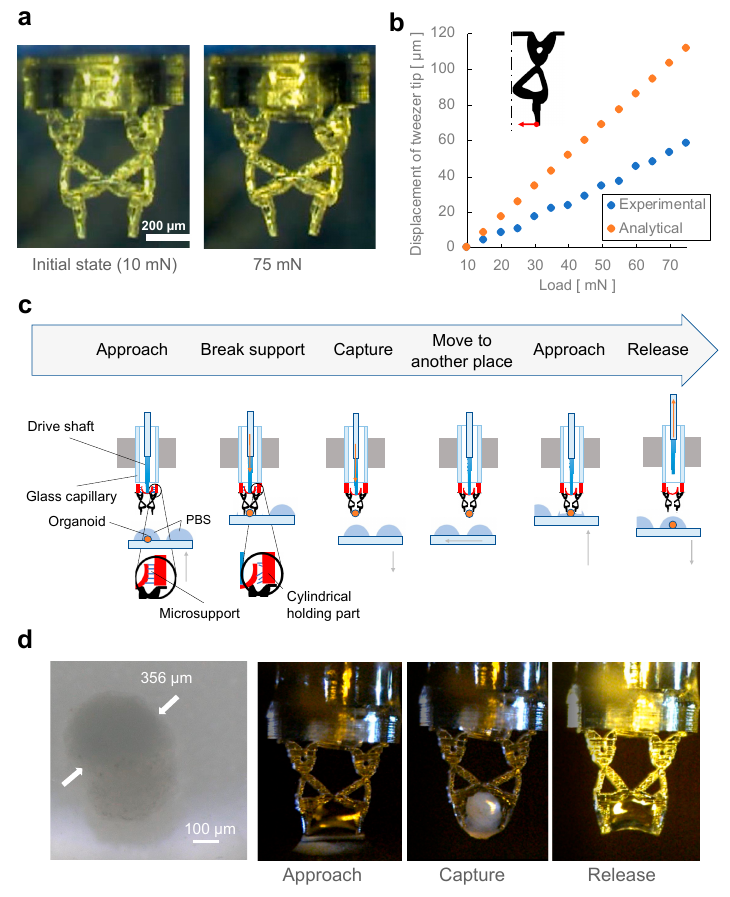
Figure 6. Evaluation of micro-tweezers and demonstration of capture and release of an organoid: ( a ) actuation of micro-tweezers with different applied loads; ( b ) comparison of simulation and experimental results of the deformation of the tweezer tip under the applied load (10 mN to 75 mN); ( c ) procedure of capturing an organoid; ( d ) optical microscopic images of an organoid and its manipulation in phosphate-buffered saline solution.